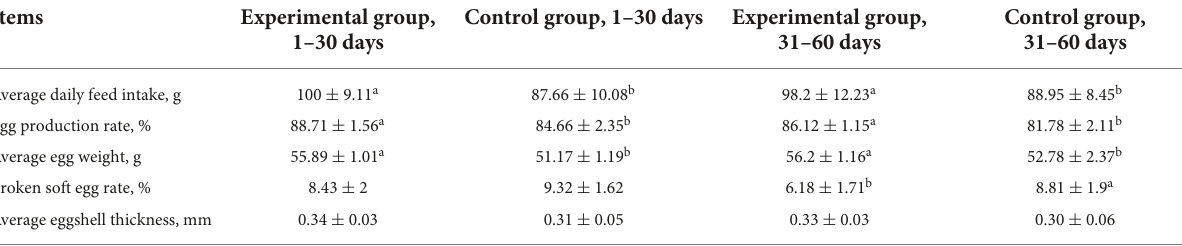
TABLE 5 Effect of mineral element fermentation complexes on production performance of laying hens.